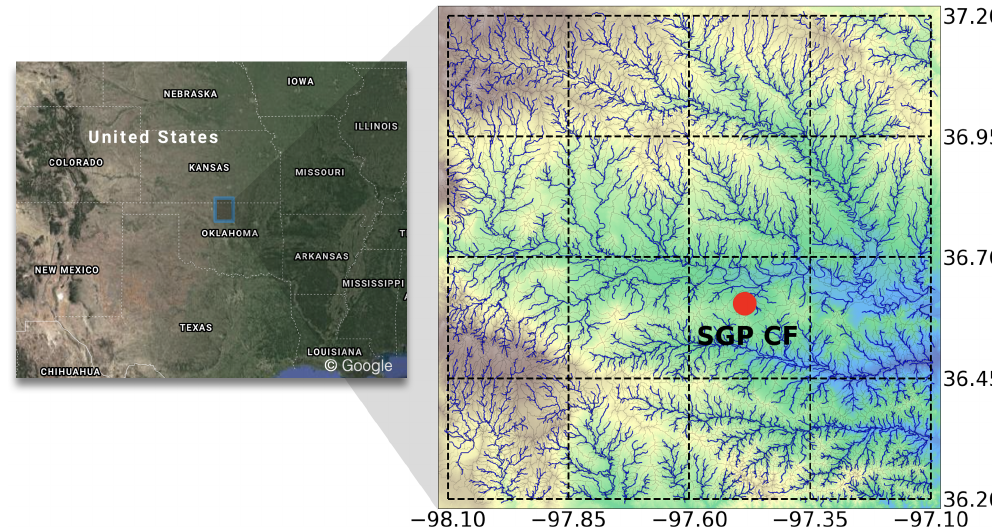
Figure 1. The study area consists of a 1.0 ◦ box in central northern Oklahoma and southern Kansas. The domain contains the Atmospheric Radiation and Measurement (ARM) Southern Great Plains central facility (SGP